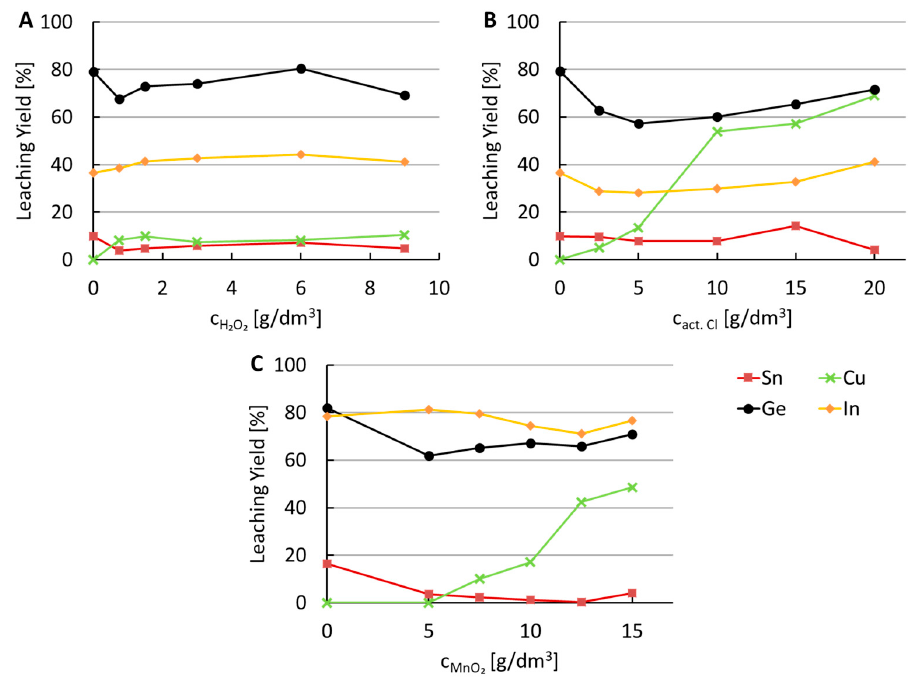
Figure 4. Leachabilities of tin, copper, germanium and indium in 10% sulphuric acid with addition of different oxidants: ( A ) H 2 O 2 (25 ◦ C, 2 h, S/L = 1/10); ( B ) HClO (25 ◦ C, 2 h, S/L = 1/10); ( C ) MnO 2 (90 ◦ C, 2 h, S/L = 1/10).